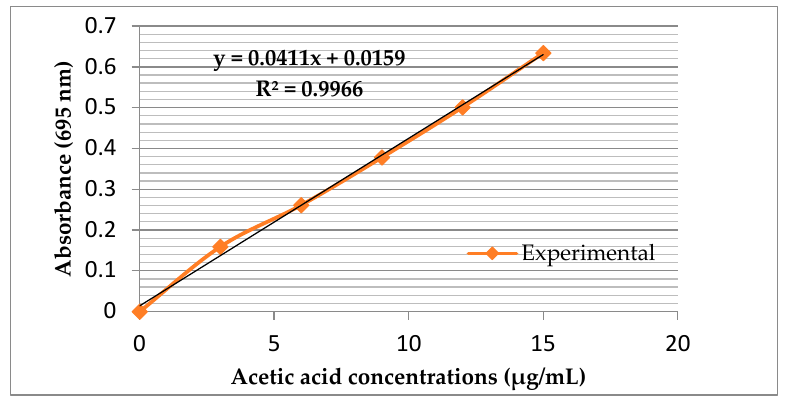
Figure 4. Calibration curve of the acetic acid (black represent linear curve).